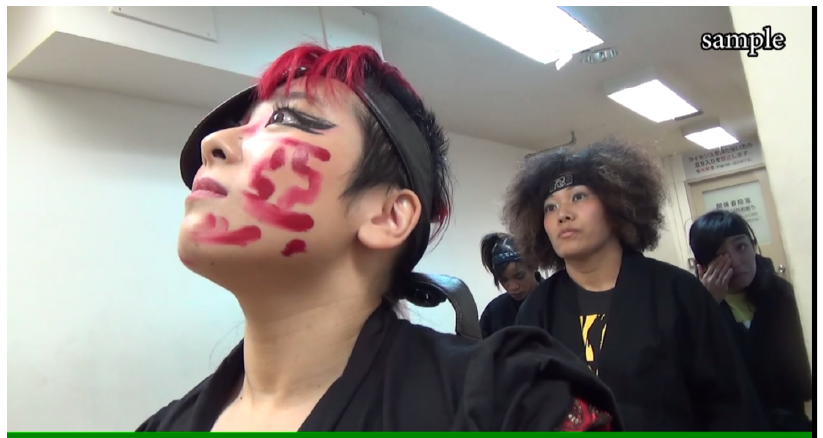
Fig. 7. The monumental stillness of Act. After Gamushara